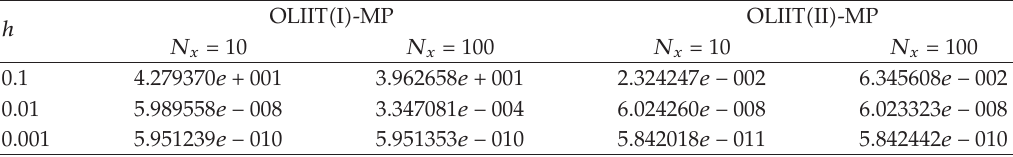
Table 10: The errors (cid:16) at t (cid:5) 10 when the algorithms are applied to the problem (cid:3) 5.6 (cid:4) with the coe ffi cients group III, where τ (cid:3) t (cid:4) (cid:5) 0 . 5 t . OLIIT (cid:3) I (cid:4)